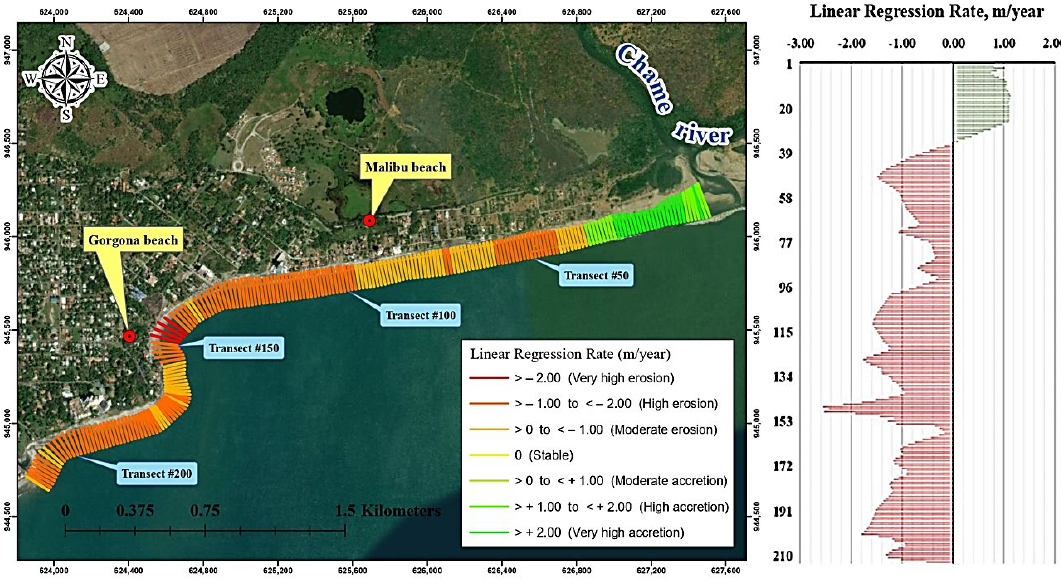
Figure 7. Erosion or accretion rates and profiles obtained by analyzing zone I by applying the Linear Regression Rate (LRR) for the period from 1998 to 2021.